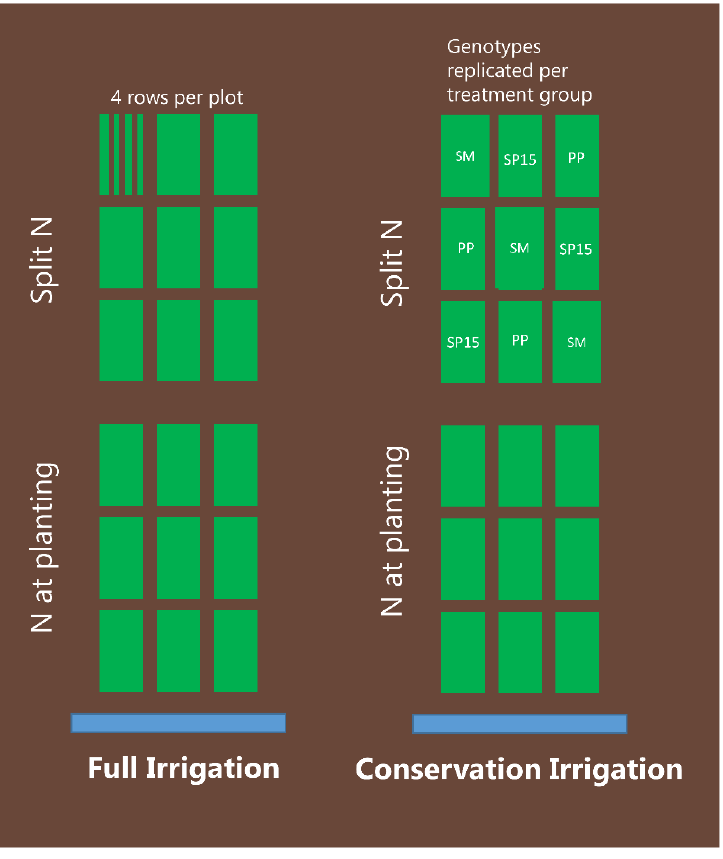
Figure 1. Design of field experiment at Los Lunas Agricultural Science Center, New